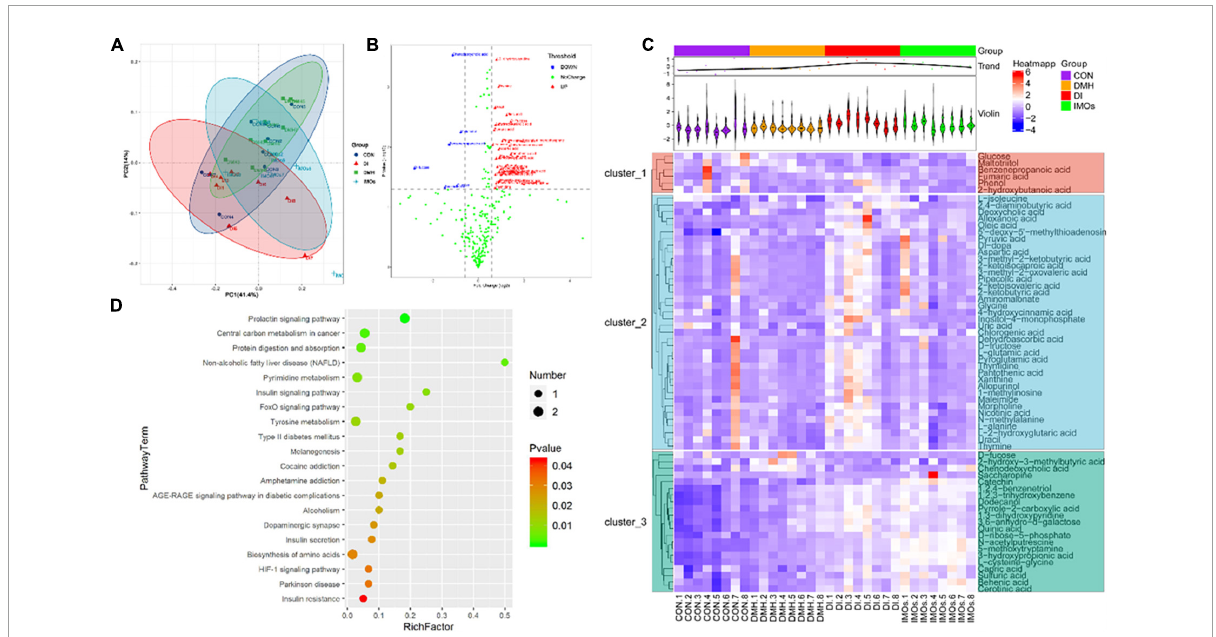
FIGURE5 Faecal metabolic profiling of the CON, DMH, DI and IMOs groups. (A) Scatter plot of PCoA scores for different groups. (B) Volcano plots present differential variables between the DMH and DI groups. Each metabolite is represented by a dot, where the red dots indicate up-regulation, the blue dots indicate down-regulation, and the green dots indicate no statistically significant difference. (C) Heatmap of 65 differentially abundant metabolites at normalized levels ( p < 0.05) among the four groups. The dendrogram shows the distances of the metabolites based on their relative abundances. The normalized abundance values are depicted visually from red to blue, representing the highest and lowest abundances, respectively. (D) Enriched KEGG pathways in the DMH group compared with the DI group. The statistical significance values ( p < 0.05) are depicted visually from red to green, representing the most and least differences, respectively. The dot sizes on the vertical axis represent the metabolite counts in the metabolic pathways.